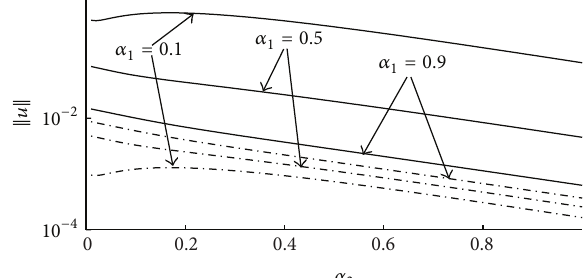
Figure 9: The dependencies for minimal control time from 𝛼 at 𝑝 󸀠 = 2 and different values of parameter 𝑎 .